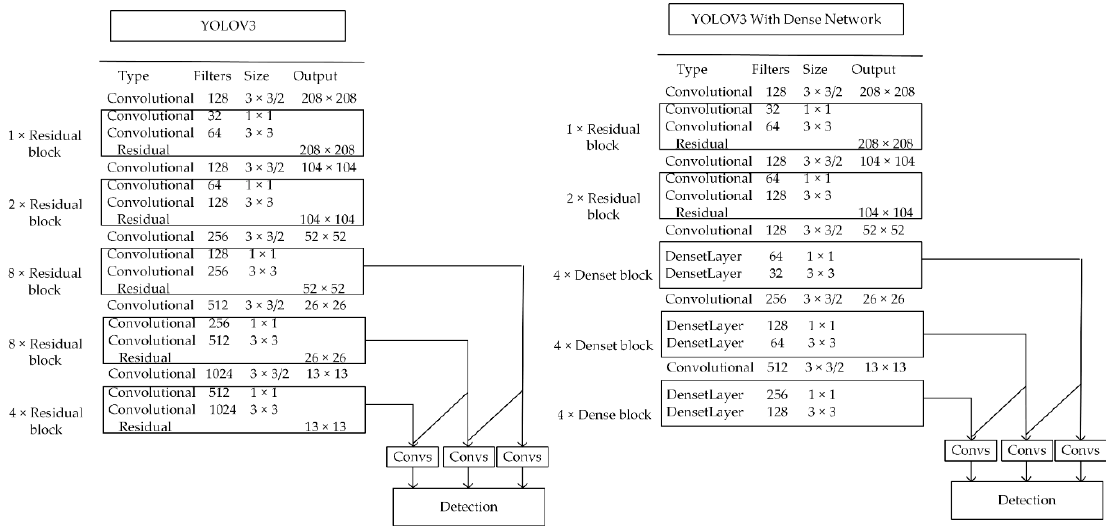
Figure 6. Bottleneck structure.